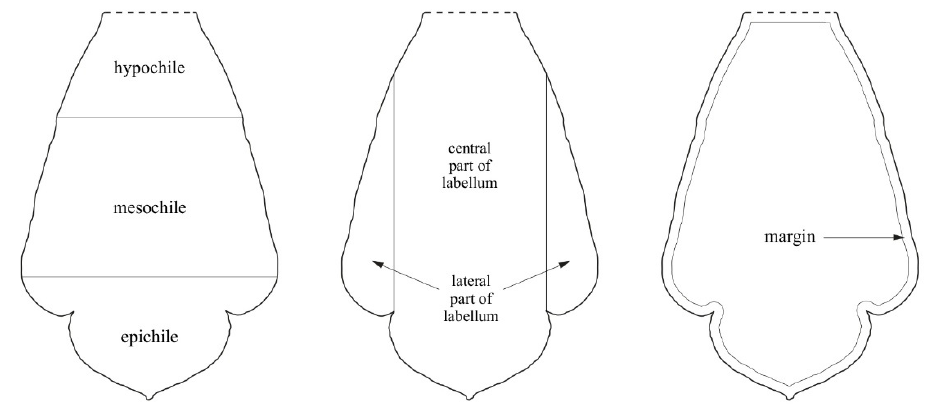
Figure 1. Terminology for parts of the labellum used in the Results